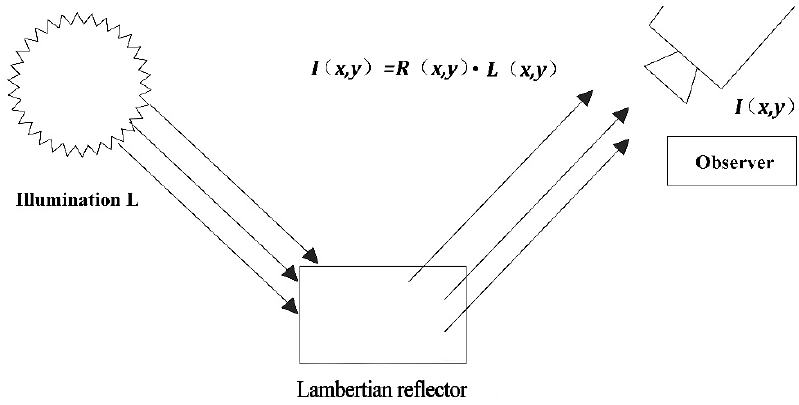
Figure 5. Schematicdiagram for Retinex.